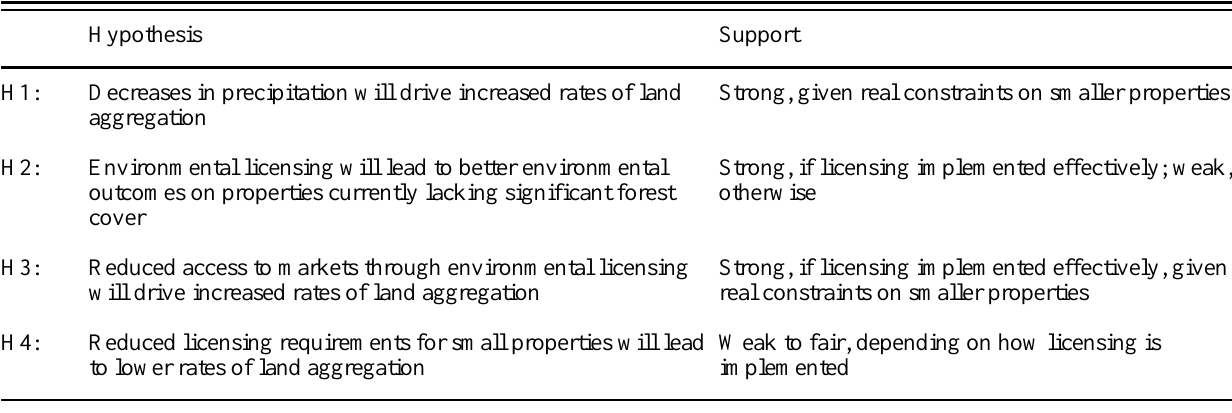
Table 3. Evidence summary for hypotheses. Hypothesis